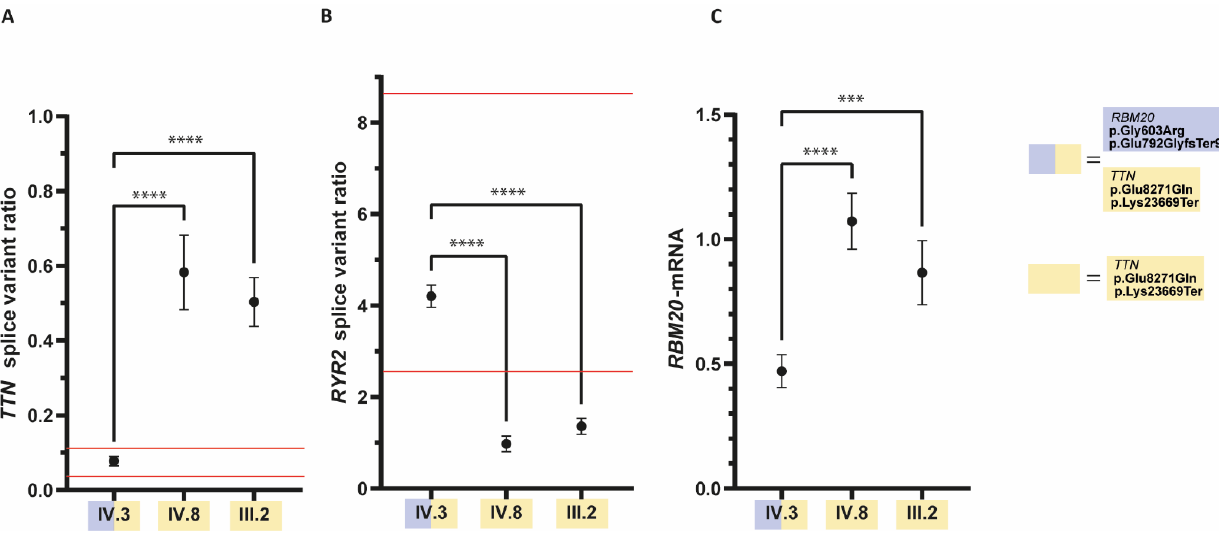
Figure 2. Quantitative real-time polymerase chain reaction (qRT-PCR) results of ( A ) TTN - ( B ) RYR2 -splice variant ratios, and ( C ) relative quantification of RBM20 mRNA. Data from affected family members with available cardiac tissue were measured as technical quintuplicates and are shown as means with standard deviation (SD). For statistical analyses one-way analysis of variance (ANOVA) with Dunnett’s multiple comparisons test was used. **** = p < 0.0001, *** = p = 0.0001. ( A , B ) The TTN - and RYR2 -splicing in the index patient (IV.3) is significantly different from the splicing in his affected relatives, who are only carriers of the TTN -mutations. The TTN - and RYR2 -splicing of IV.3 are within the previously defined reference range [10] for pathogenic RBM20 mutations (red lines). ( C ) qRT-PCR analysis revealed decreased RBM20 mRNA expression in the RBM20 mutation carrier IV.3 in comparison to his relatives.